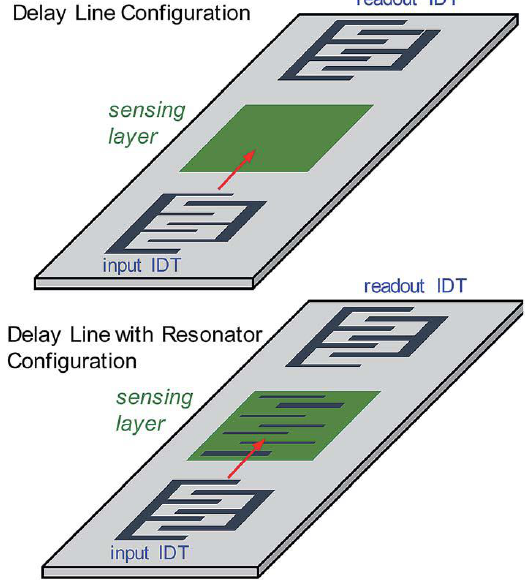
Figure 9. The delay line configuration setup with and without resonator [17].